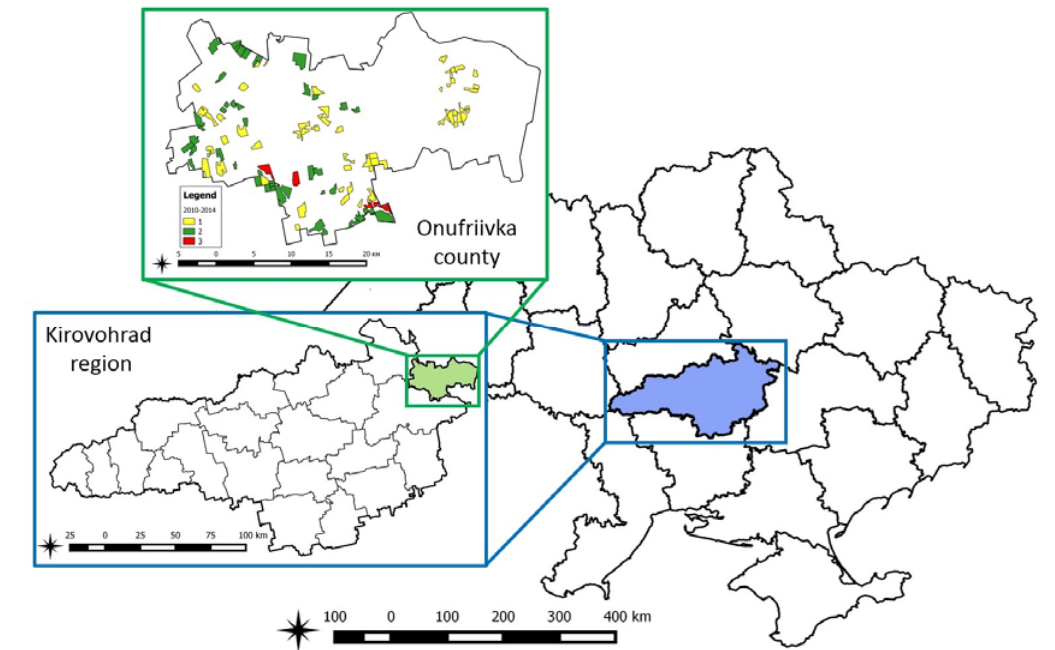
Figure 1. The area of investigation at different scales: Kirovohrad region, Onufriivka county and fields with winter, grown for 1 (yellow), 2 (green) and 3 (red) years since